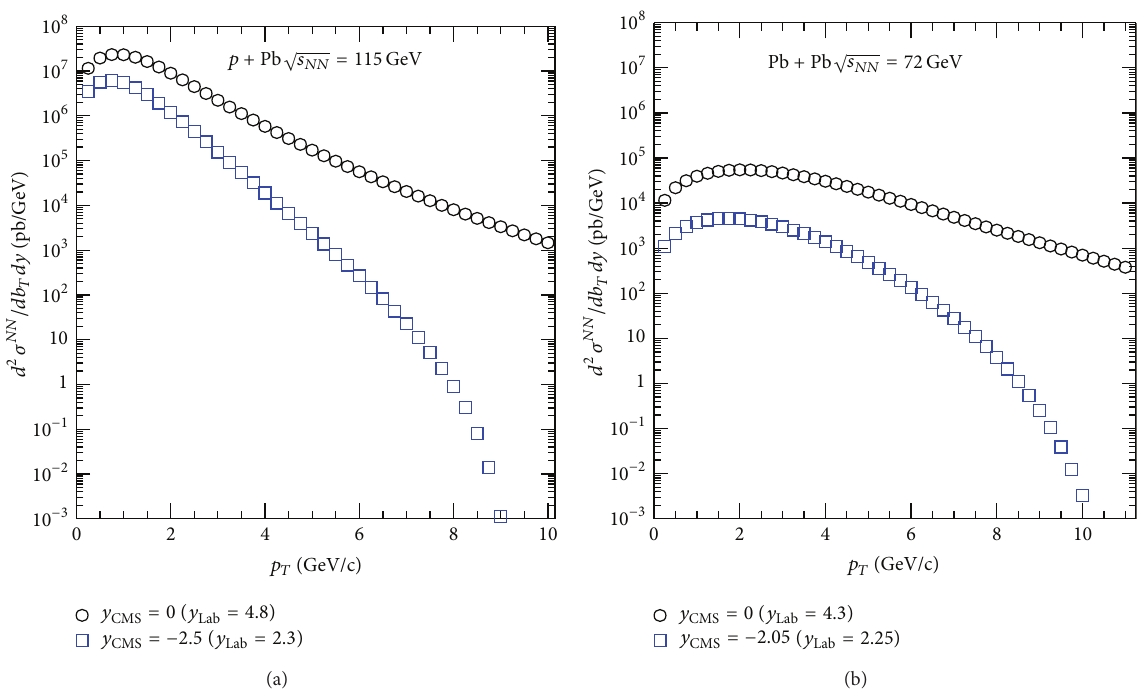
Figure 3: Charm quark differential cross section per nucleon-nucleon collision as a function of 𝑝 𝑇 in p + Pb and Pb + Pb